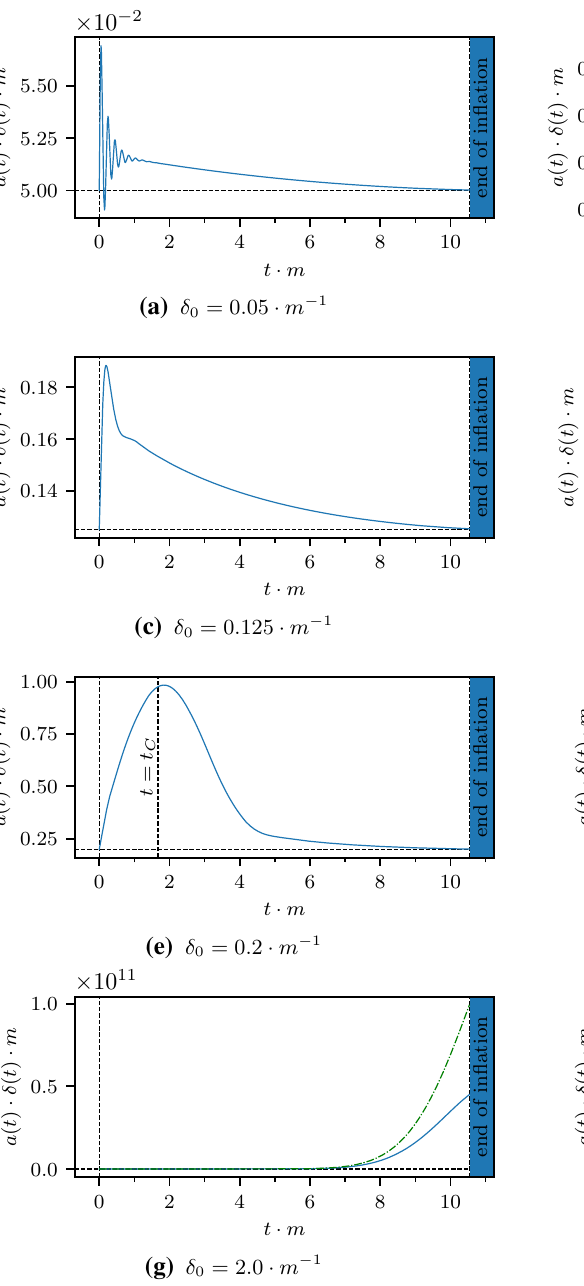
Fig. 3 Timedependenceofphysicalthicknessofthewall, a ( t ) · δ( t ) · m , for different values of the initial wall thickness, δ 0 , in the (cid:9) 2 -model. Dashed horizontal line corresponds to δ 0 . The time at which the infla- tion ends is shown by vertical dashed line with the corresponding label.